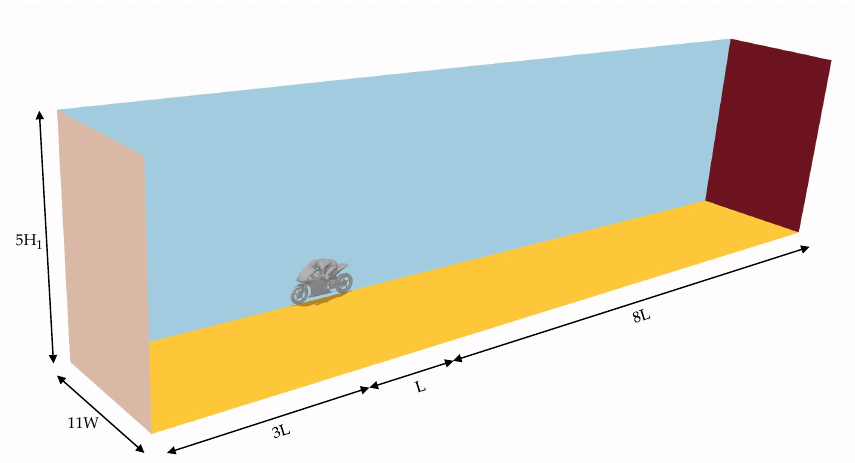
Figure 2. Dimensions of the computational